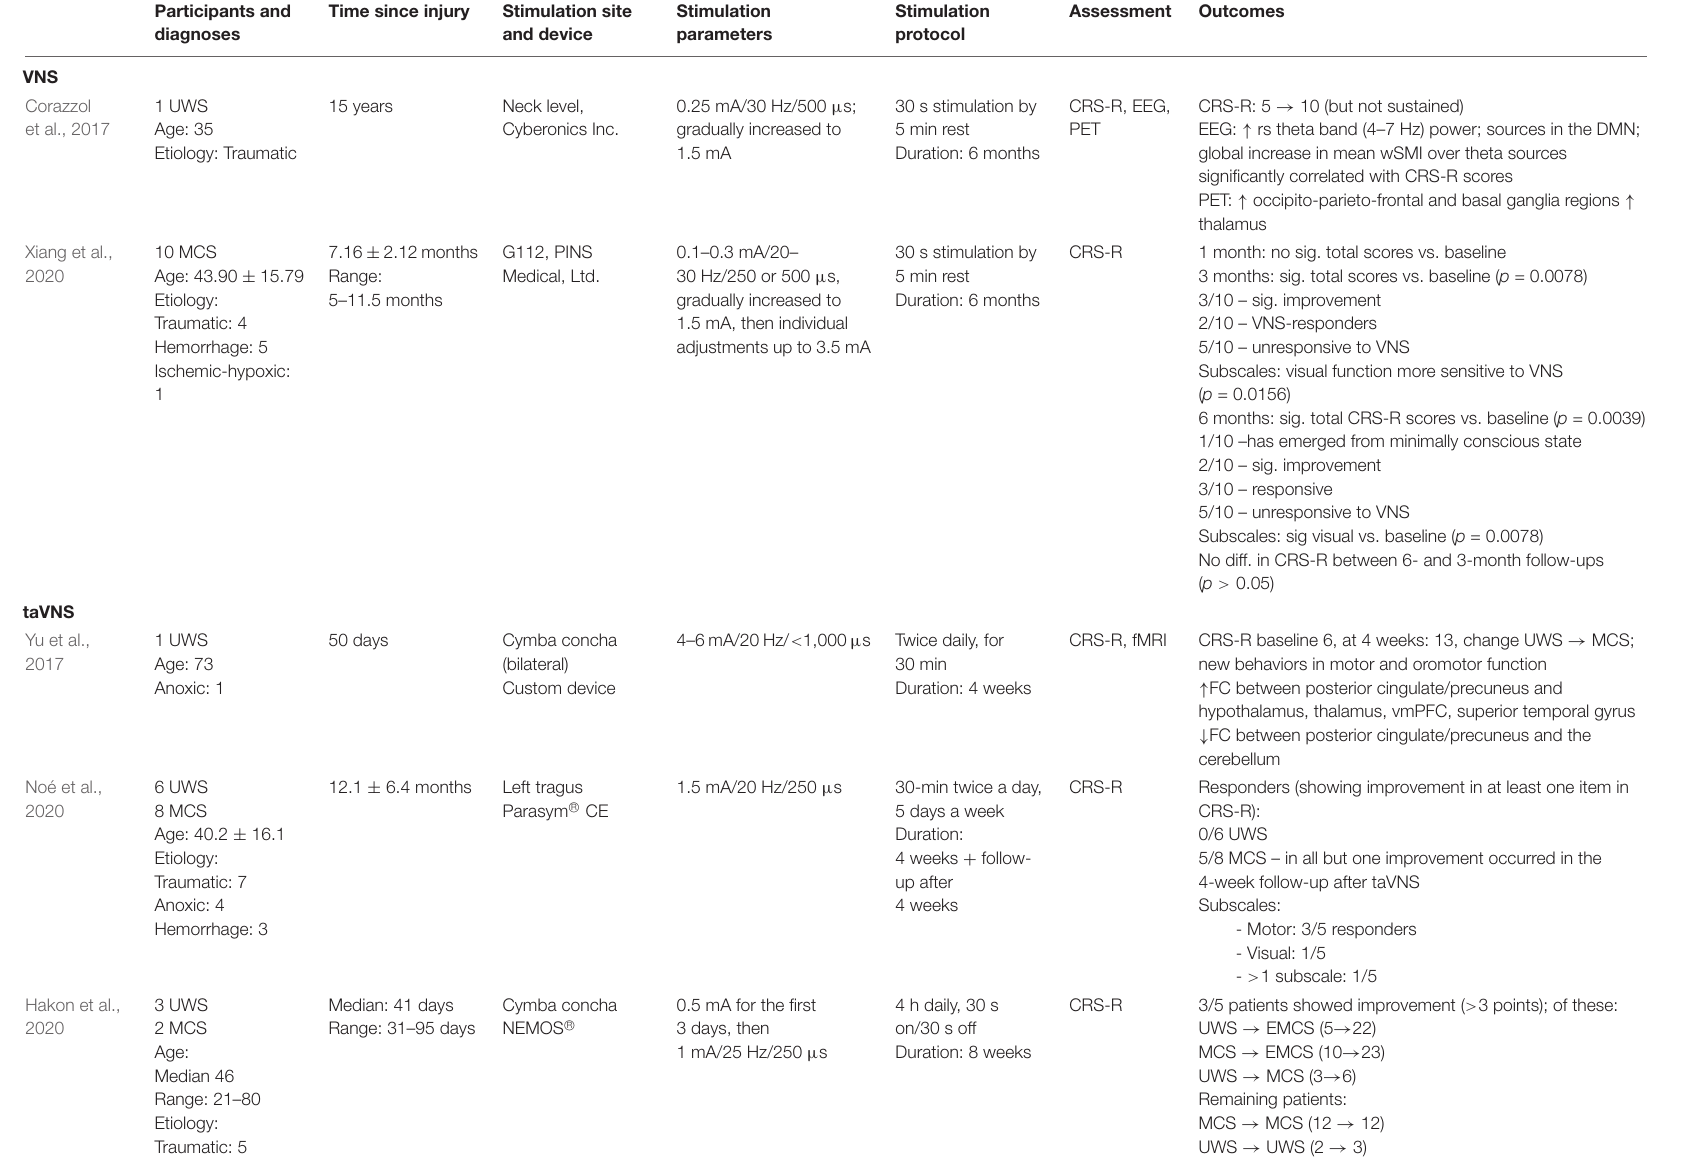
TABLE 1 | A summary of VNS and tVNS studies on DoC patients. Participants and Time since diagnoses